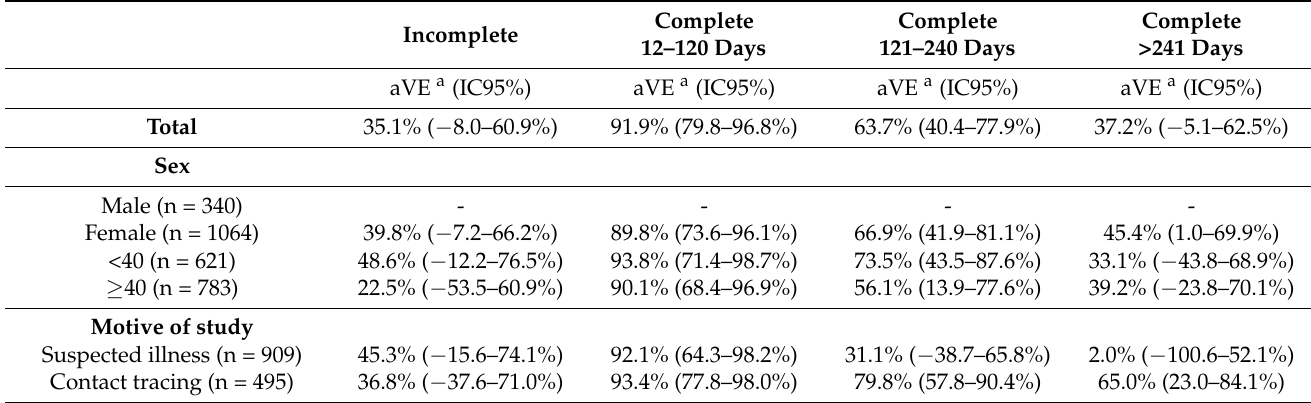
Table 3. Adjusted vaccine effectiveness according to the time elapsed since the completion of the vaccination regimen (n =